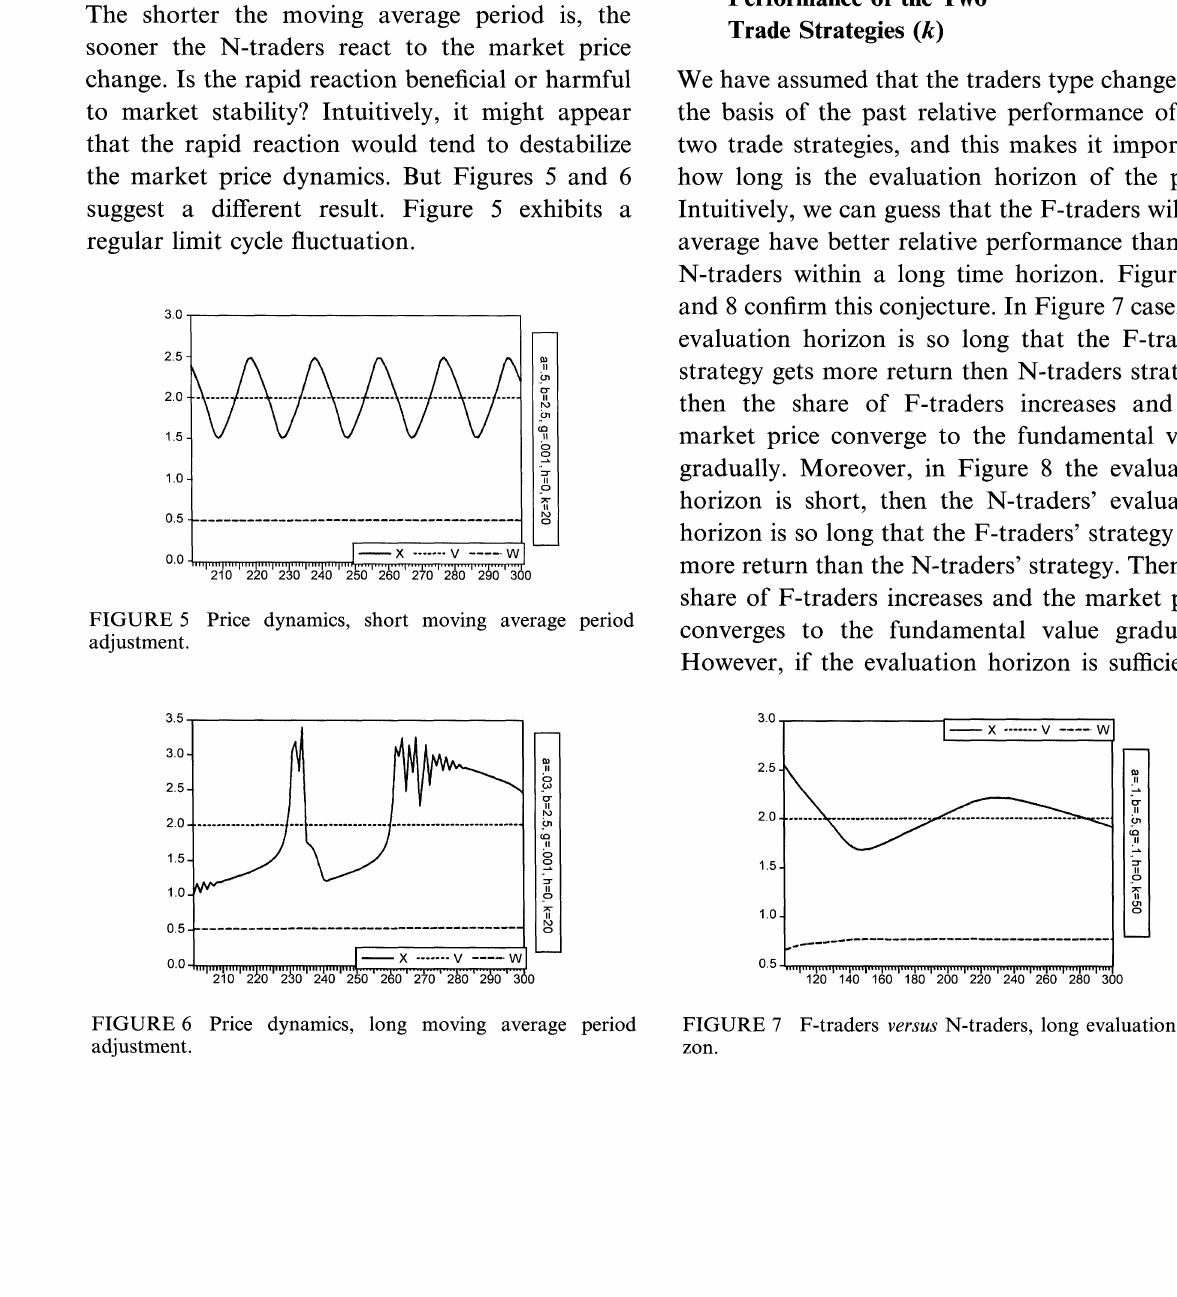
FIGURE 6 Price dynamics, long moving average period adjustment.